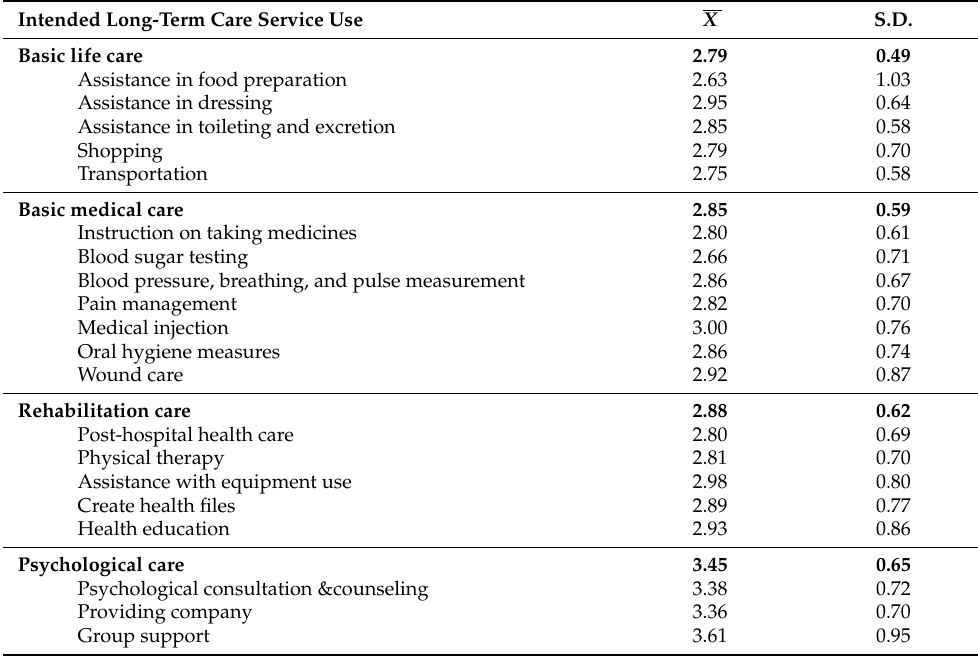
Table 2. Participants’ Intended Use of Four Types of Long-Term Care Services ( n = 239).